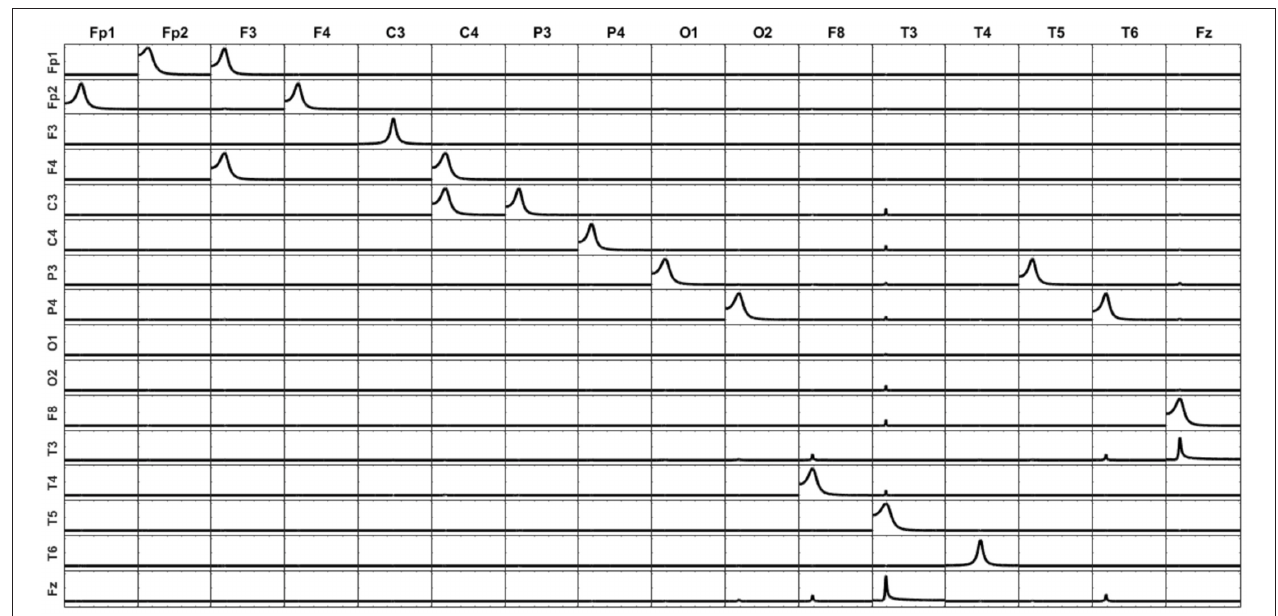
FIGURE 10 | The unmixing procedure was carried out with the 17 point sources (including F7), but iCoh was computed based on the 16 sources resulting from removing F7. The variance due to F7 is then unknown for the iCoh measures. The connectivity patterns between all variables are preserved, except a bidirectional connection between Fz and T3. Note that this connection exists in the original system, mediated by F7, which has been removed. Small artifacts appear because the voxels without signal were set to random noise. If no noise is added to these voxels, the reconstruction does not show artifacts.